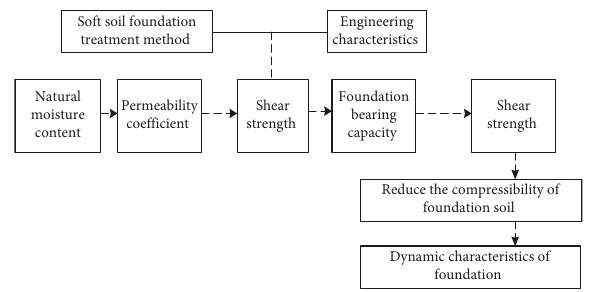
Figure 2: Flow chart of the land-based processing